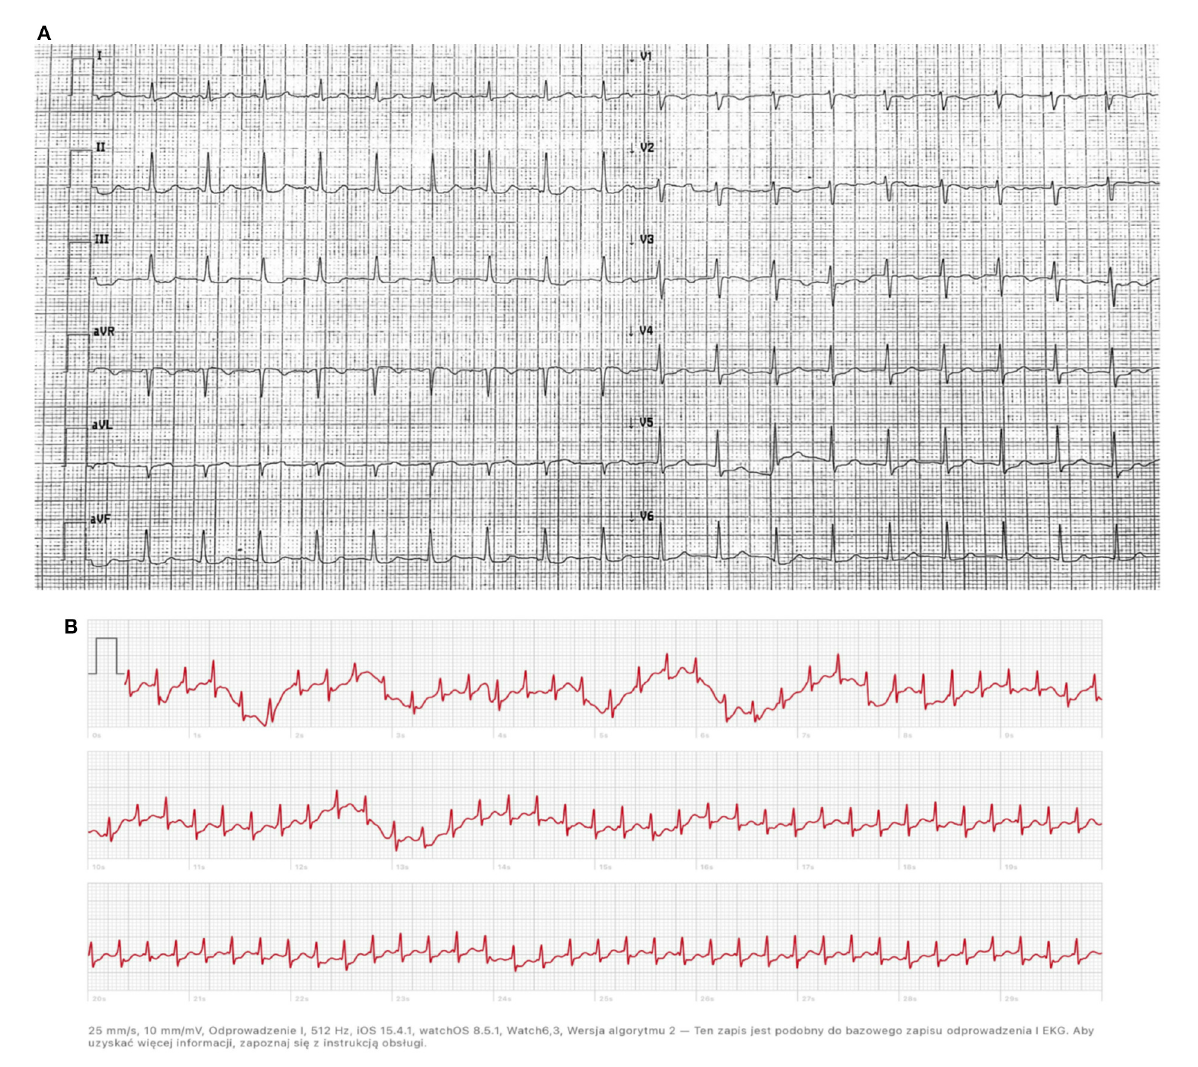
FIGURE1 (A) ECG on admission to hospital: sinus tachycardia 113 bpm, normal cardiac axis, T-waves inversion in leads V1 - V3; (B) Recording from Apple Watch: narrow QRS complex tachycardia of 216 bpm with short RP interval.